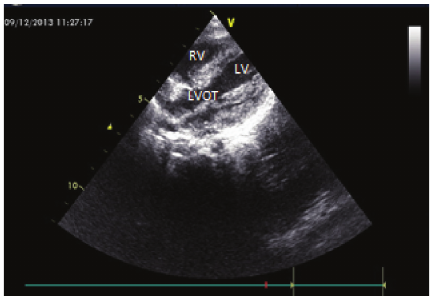
Figure 2: Echocardiography showing a significant diminish in the mass size (in the postnatal 28